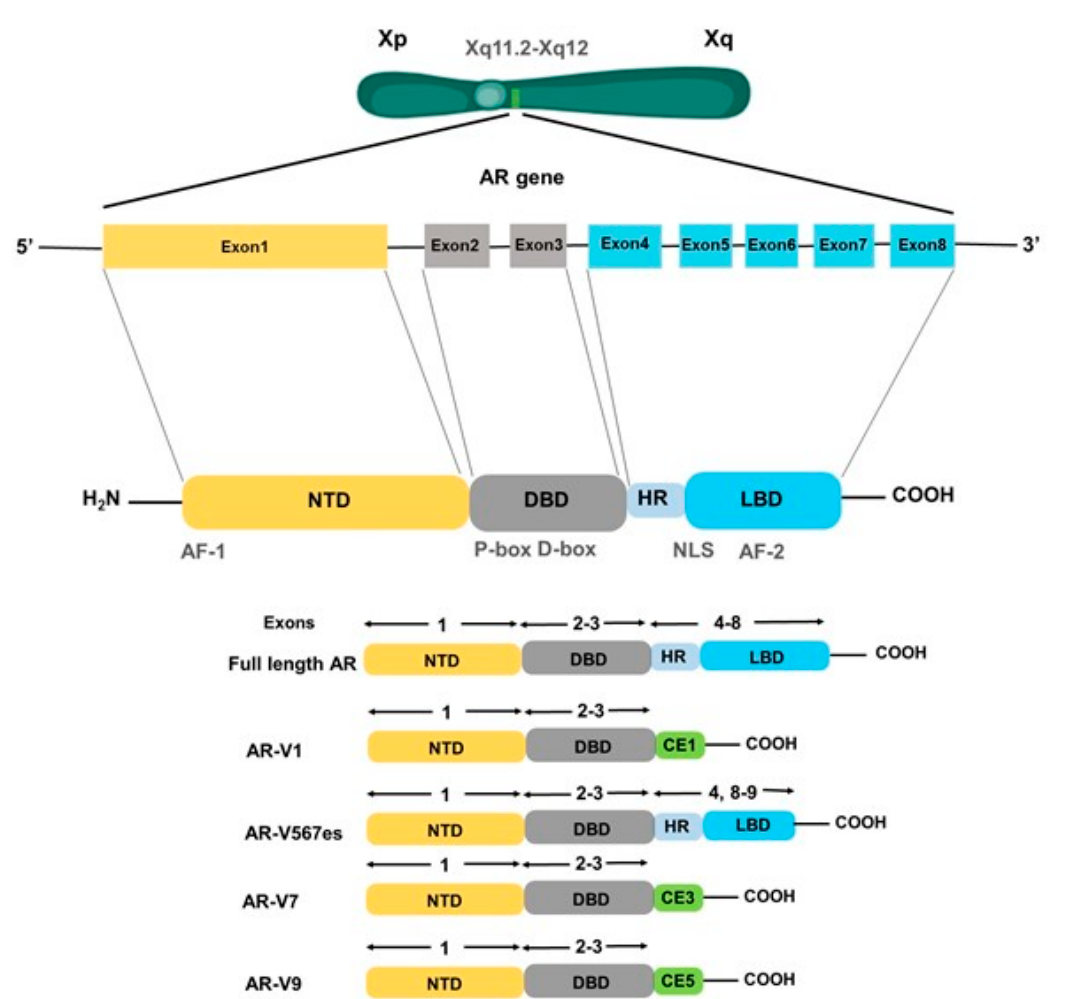
Figure 2. Genomic organization of the AR gene and frequently reported androgen receptor (AR) splice variants. The gene encoding for androgen receptor is localized on the long arm of chromosome X in the region Xq11.2-q12. It is comprised of 8 exons that code for the mature androgen receptor protein having three functional domains: N-terminal binding domain (NTD), DNA binding domain (DBD), and a carboxy-terminal ligand binding domain (LBD) that is separated from DBD by a short hinge region (HR). Exon1 encodes for the NTD, exon 2–3 encode for the DBD, exon 4–8 encode for the hinge region and LBD. Several AR splice variants have been reported that show truncation at DBD or LBD. AR-V1 is truncated at the end of exon 3 and contains 19 amino acids from cryptic exon 1 (CE1). AR-V567 is created by skipping of exons 5–7 in the AR mRNA, while AR-V7 has splicing of cryptic exon 3 (CE3) after exons 1–3, and AR-V9 is generated by splicing of cryptic exon 5 (CE5) after exon 3. AR-V1, AR-V7, and AR-V9 all lack LBD.